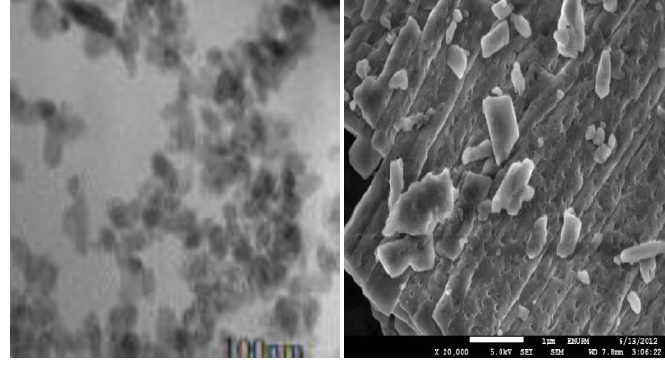
/Dox nanocrystal and ( b ) FESEM micrograph of CaCO 3